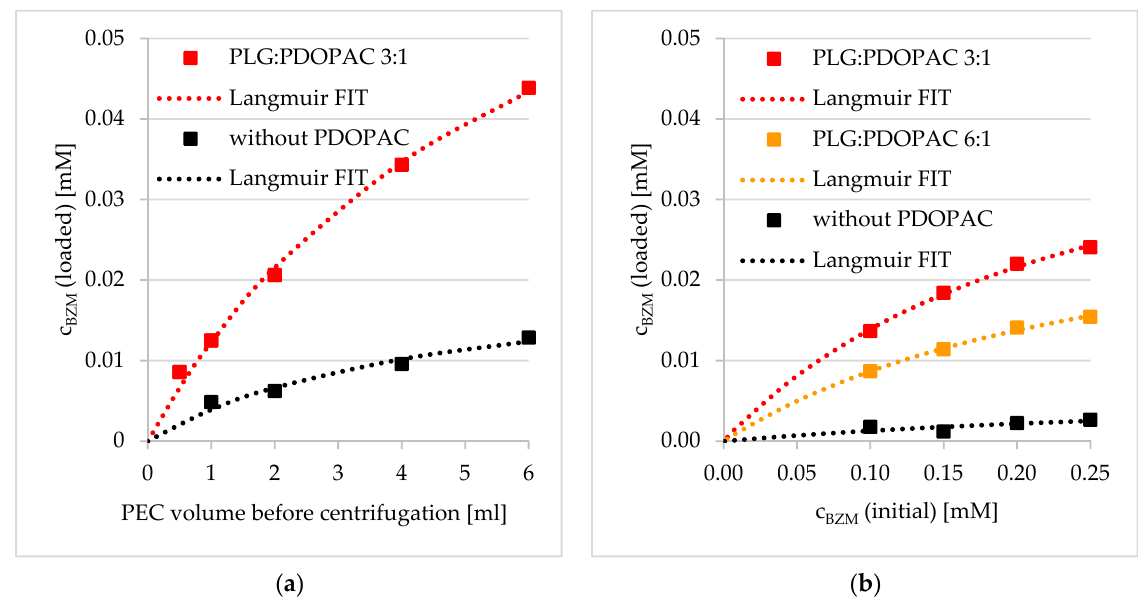
Figure 7. Loading capacity of PDOPAC/PEC in dependence of ( a ) volume of the dispersion and ( b ) initial BZM concentration for two different polyanion ratios (preloading).